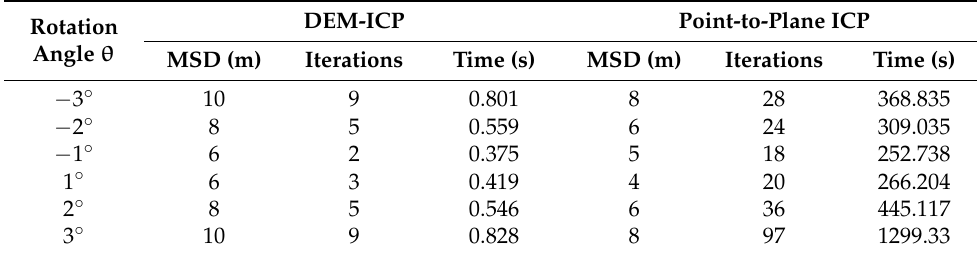
Table 4. Comparison of registration parameters. Here, MSD represents the maximum search distance for corresponding points during registration, which is an important registration parameter. In other words, two different points located on two point clouds; if the distance between them is greater than the MSD, then they will not be recognized as a pair of corresponding points.